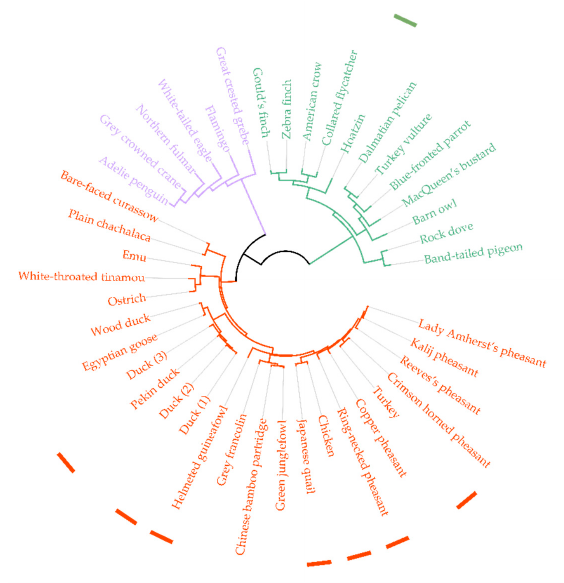
Figure 5. Phylogenetic tree of avian GH22 lysozymes, marked with different colours for different types of birds (red: chicken-like, violet: seabirds, and green: “other birds”/“upper gut”). Truncated sequences were omitted from the analysis and sequences that are more than 98% identical are shown as one entry. Known 3D structures in the PDB are indicated by coloured squares (green: Oh Lys and red: pdb). A list of sequence identifiers (common name, scientific name, database ID and cluster sizes can be found in Supplementary Table S1.